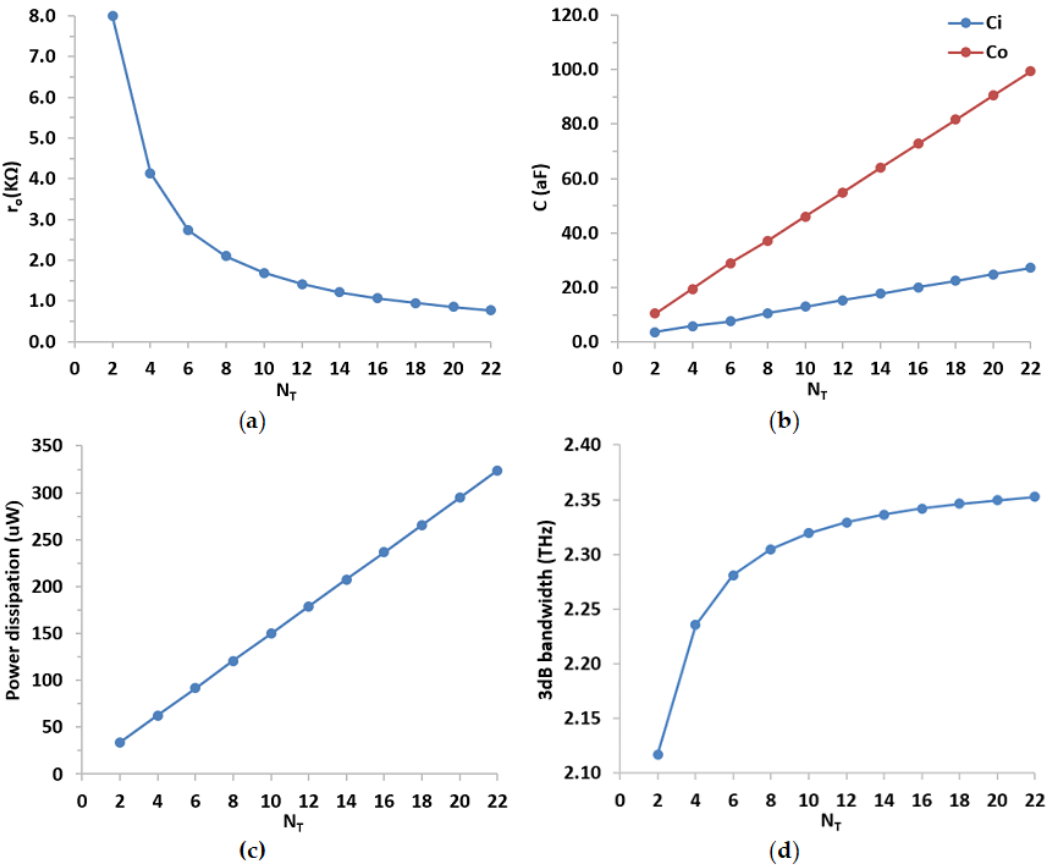
Figure 4. Effect of variation of N T on unity gain inverting amplifier (UGIA): ( a ) r o ; ( b ) C i and C o ; ( c ) Power dissipation; ( d ) − 3 dB